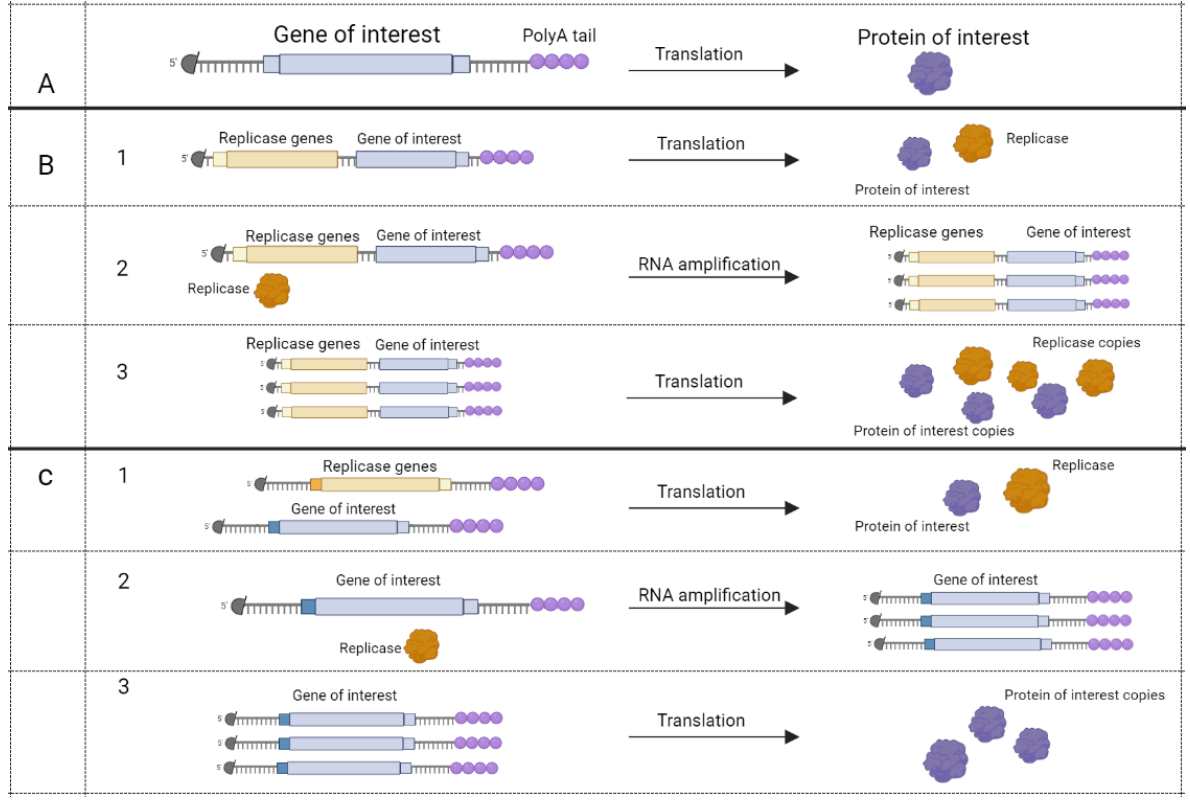
Figure 4. mRNA vaccines’ method of action [40]. Five-prime cap (black circle) and polyA tail present on all mRNAs. ( A ), conventional mRNA encodes protein that may be used as an antigen.Apart from the gene of interest, self-amplifying mRNA (SAM) may encode RNA dependent RNA polymerase (RDRP) at the same molecule ( B ) or at the other mRNA ( C ). ( B , C ), step 1, translation of RDRP and gene of interest. Step 2, RDRP amplifies mRNA. Step 3, translation of self-amplified mRNA. Figure was created using BioRender